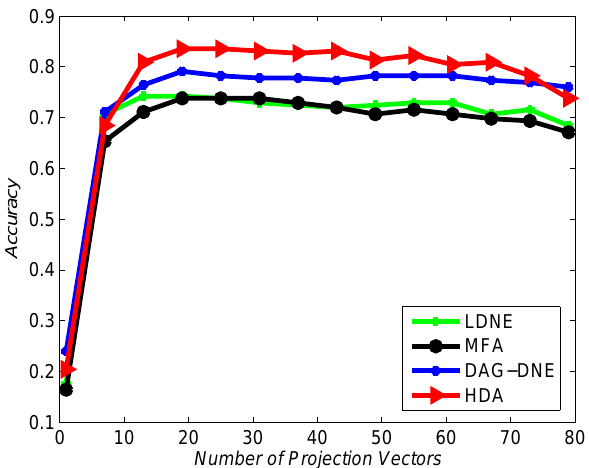
Figure 5. Accuracy vs. Number of Projection Vectors on the Yale dataset under K = 3.